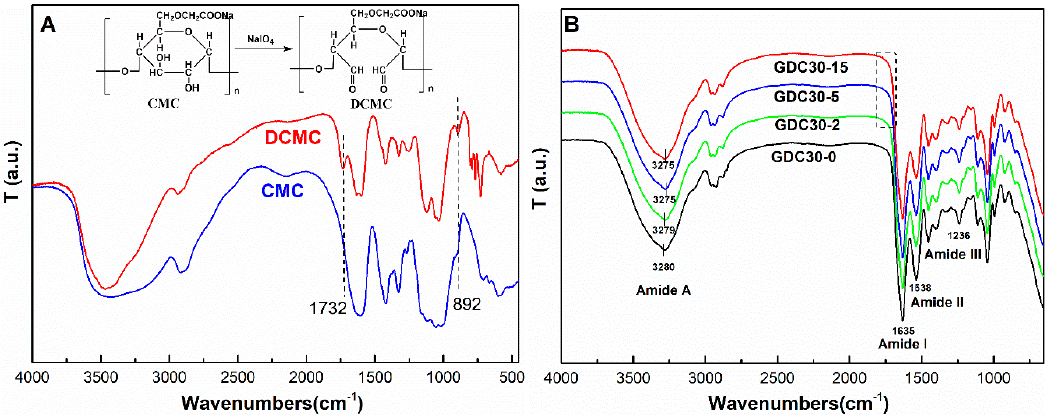
Figure 2. FTIR spectra of ( A ) CMC, DCMC and ( B ) FK/DCMC films.